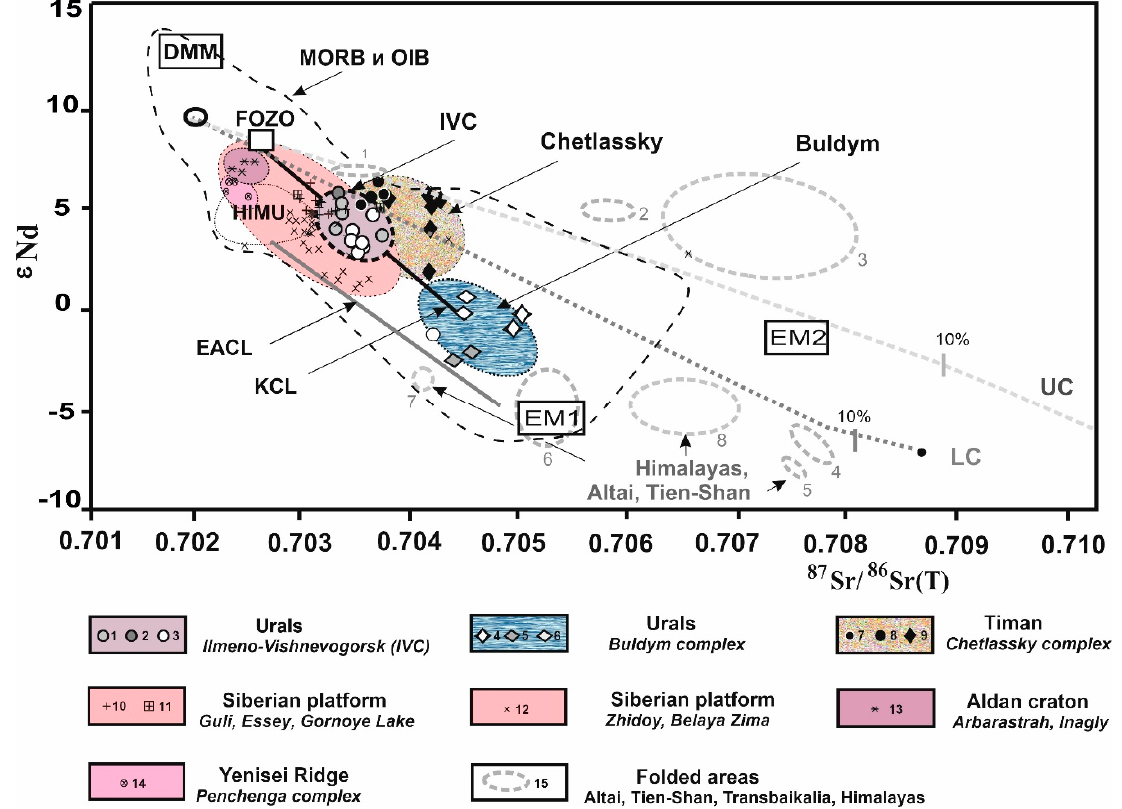
Figure 11. ε Nd— 87 Sr/ 86 Sr(T) diagram for carbonatite complexes of the Urals and Timan in comparison with carbonatite complexes of shields and platforms: Kola province (KCL) [33,38], East African Province (EACL) [32], East Siberian platform and its framing [121,172–176], the Aldan Shield [173], and with collision carbonatite complexes of folded regions: Altai, Tien Shan, Transbaikalia, Himalayan [8,9,12,17,20–22,42,43]. The elongated dotted line limits the field of mantle isotopic compositions [41]. The Kola carbonatite line (KCL) [33] and the East African carbonatite line (EACL) [32]. The mantle end-members: DMM, EM1, EM2 are given in accordance with their modern isotopic signatures [115,116,118]. FOZO—mantle reservoir according to [116,118]. To calculate the DM–LC mixing line, values of the DM source: 143 Nd/ 144 Nd 440 = 0.512534 ( ε Nd = +9.05), 87 Sr/ 86 Sr 440 = 0.70187, Sr = 6 ppm, Nd = 0.33 ppm according to [123] and the lower crust (LC): 143 Nd/ 144 Nd 440 = 0.511694 ( ε Nd = − 7.4), 87 Sr/ 86 Sr 440 = 0.7087, Sr = 370 ppm, Nd—30 ppm according to [177] were used. 1, 2: Ilmeno–Vishnevogorsk complex (IVC), South Urals (Pz): 1—miaskites, 2—syenites, 3—carbonatites (sövites I, II); 4–5: Buldym complex, South Urals: 4—ultramafic rocks, 5—carbonatites (sövites III), 6—beforsites; 7–9: Chetlassky complex, Middle Timan (V): 7—carbonatites, 8—carbonate-bearing lamprophyres, 9—picrites and lamprophyres; 10–12: carbonatite complexes of the East Siberian platform and its framing: 10—Guli, Essey, Maymecha-Kotui province (Pz); 11—Gornoye Lake, Sette-Daban province (Pz); 12—White Winter, Middle Winter, Zhidoy, East Sayan province (V); 13—Arbarastrakh, Inagli, Aldan Shield (V), 14—Penchenginsky, Yenisei ridge (RF 3 -V); 15—collision carbonatite complexes of fold regions—Altai, Tien Shan, Transbaikalia, Himalayas (1—Edelweiss, 2—Upper Petropavlovsk, Altai-Sayan fold region (Pz); 3—Kharly,